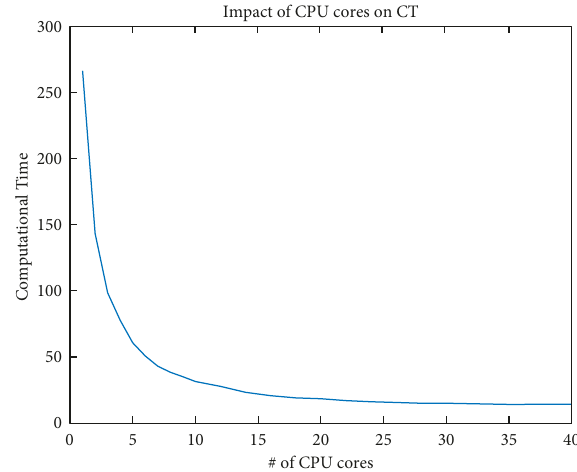
Figure 11: Impact of CPU cores on